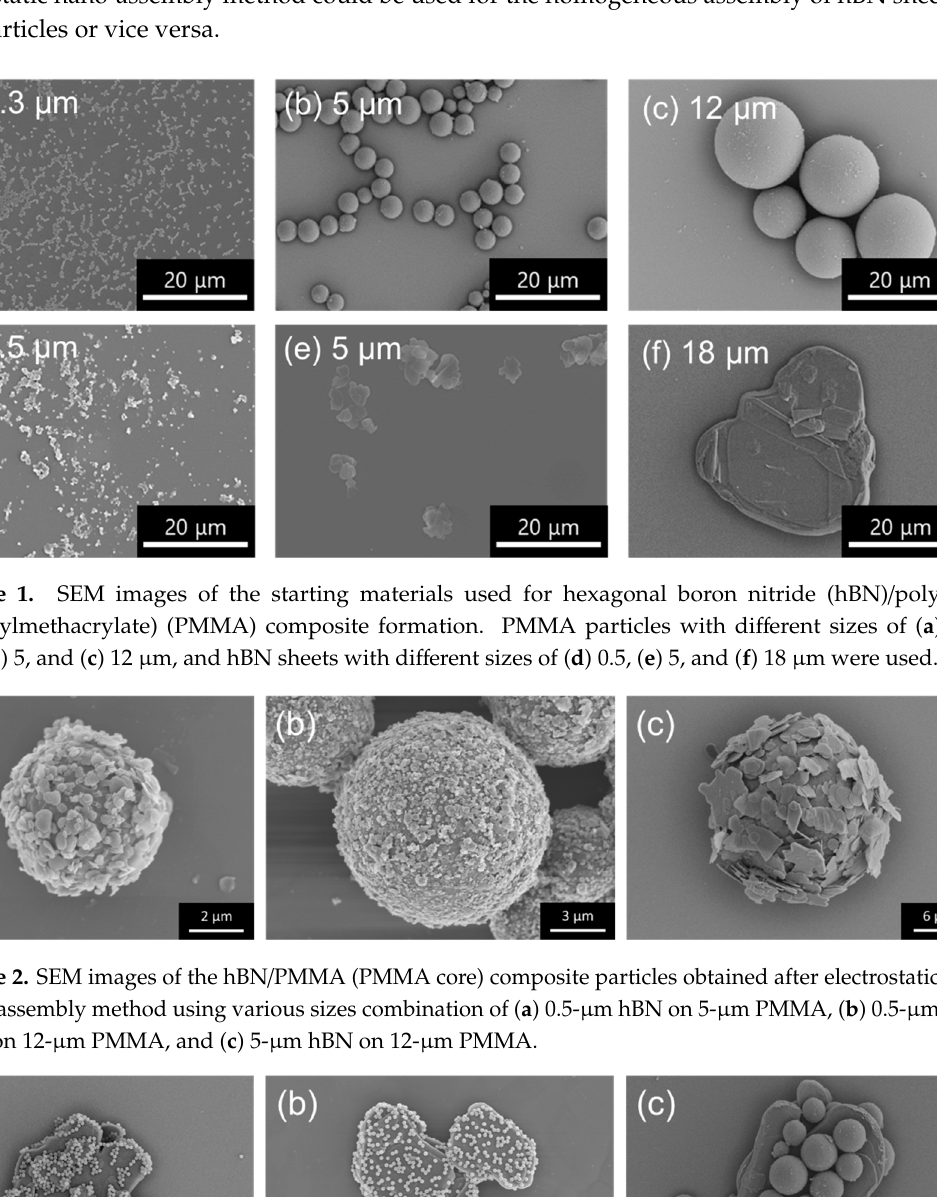
Figure 3. SEM images of the PMMA/hBN (hBN core) composite particles obtained after electrostatic assembly, using various combinations: ( a ) 0.3-µm PMMA on 5-µm hBN sheets, ( b ) 0.3-µm PMMA on 18-µm hBN sheets, and ( c ) 5-µm PMMA on 18-µm hBN sheets.